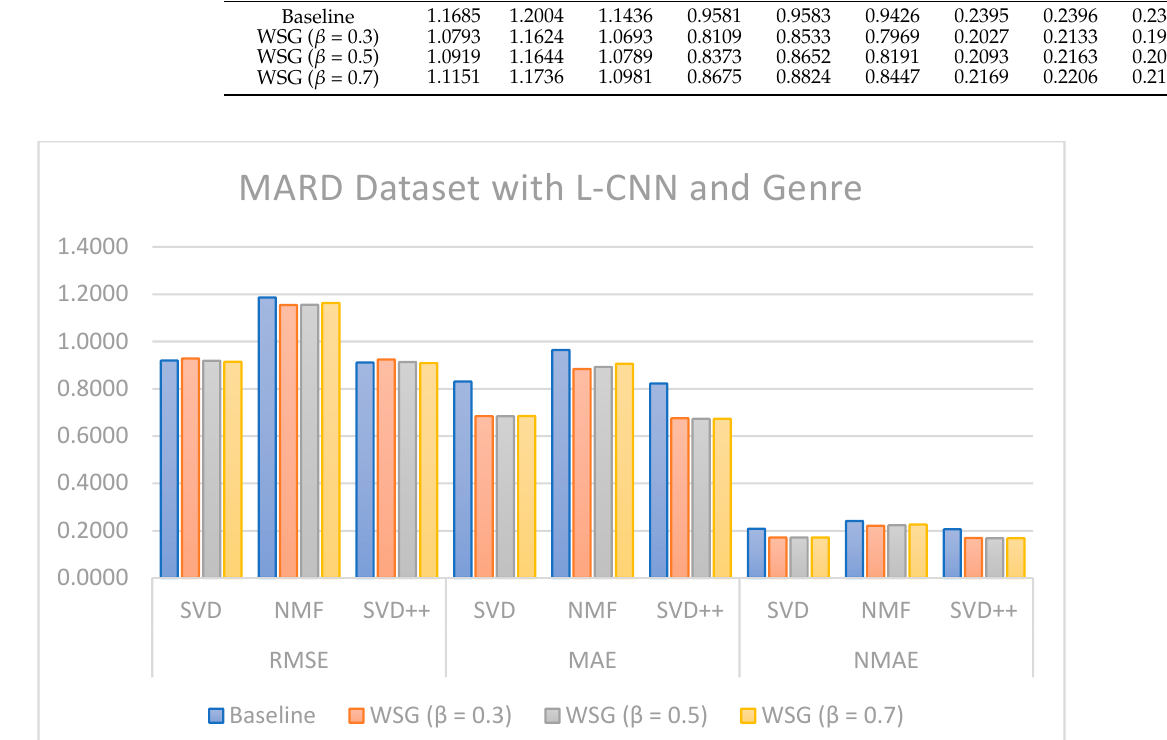
Figure 8. RMSE (Root-Mean-Square Error), MAE (Mean Absolute Error), and NMAE (Normalized MAE) values with and without L-CNN sentiment and genres-based model and different values of β on the MARD dataset. Table 6. RMSE, MAE, and NMAE values with and without C-LSTM sentiment and genres-based model and different values of β on the MARD dataset.